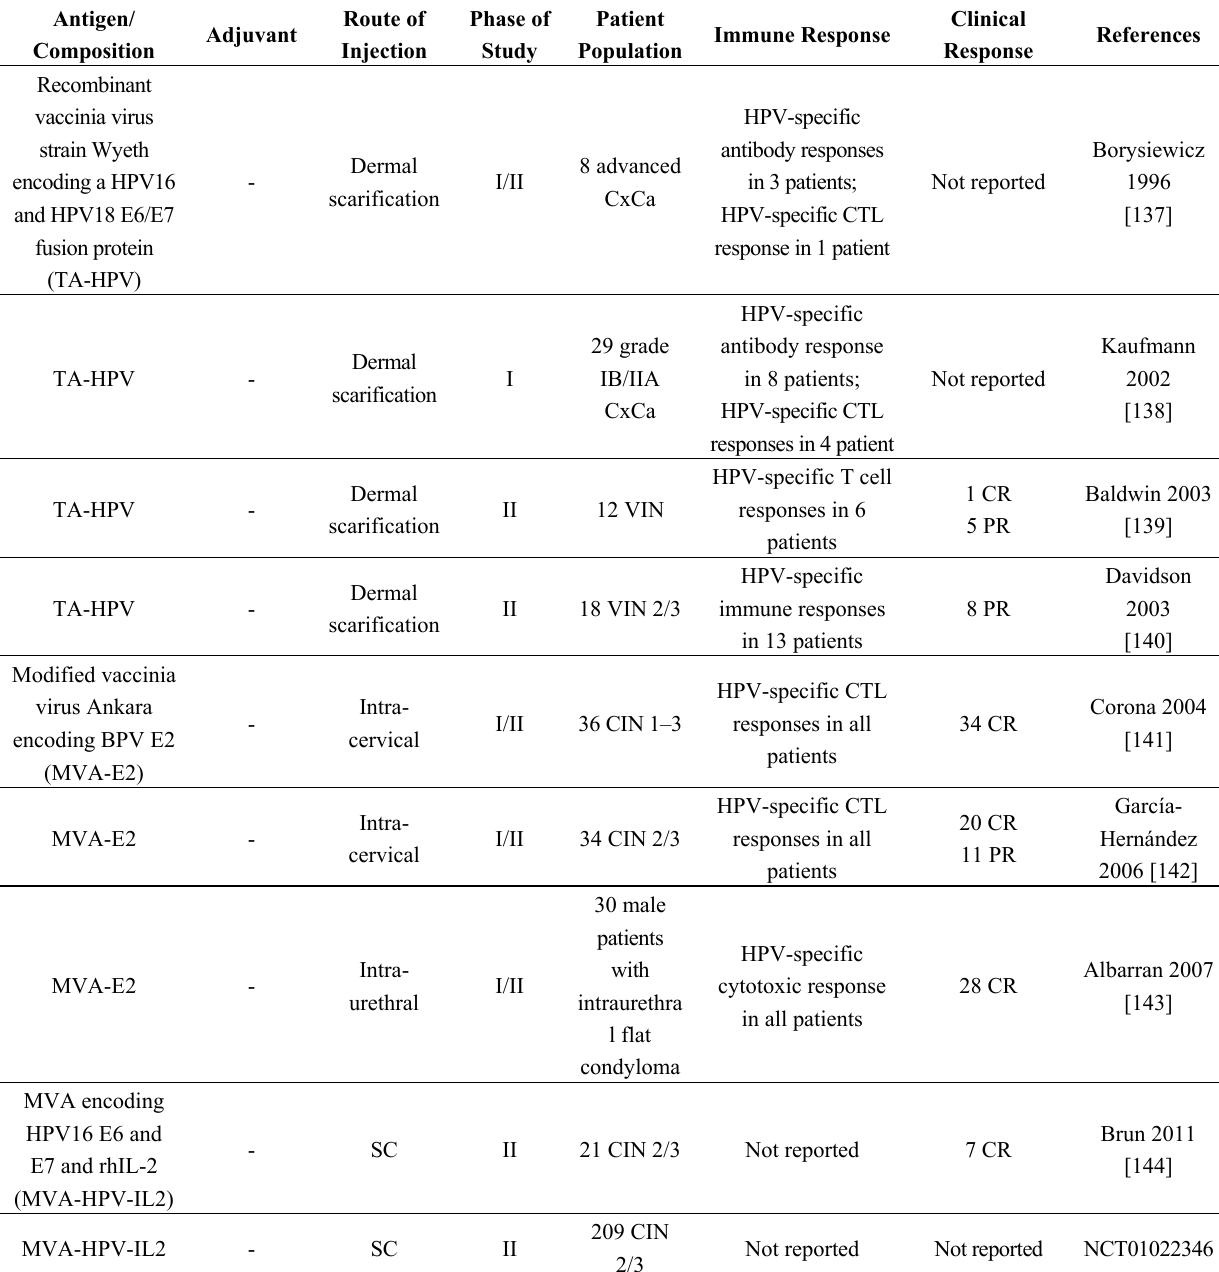
Table 5. Clinical studies with viral vector